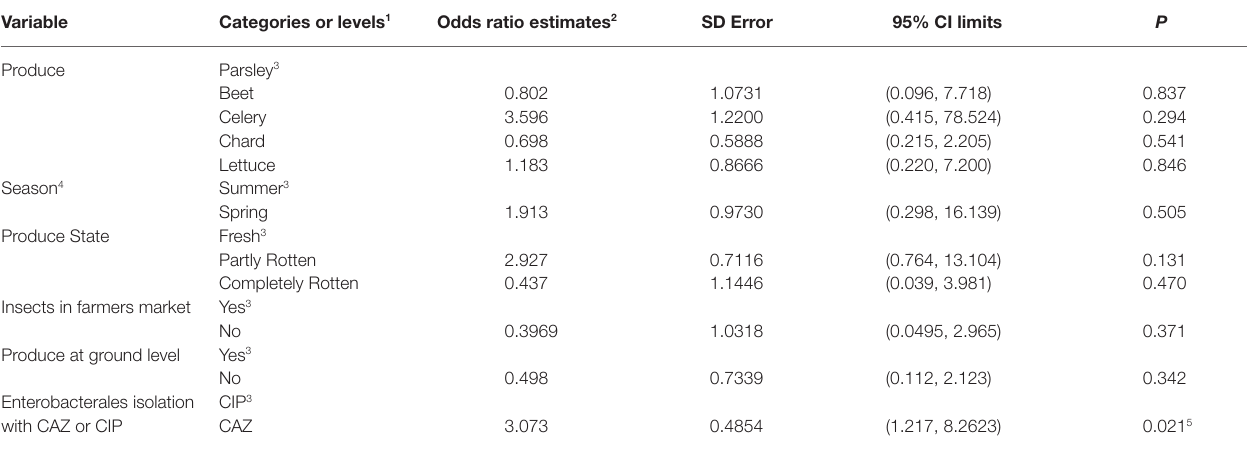
TABLE 4 | Multivariable generalized linear model showing risk factor associations between environmental factors and isolation of MDR Enterobacterales strains isolated from vegetables collected in November 2019 and January 2020.